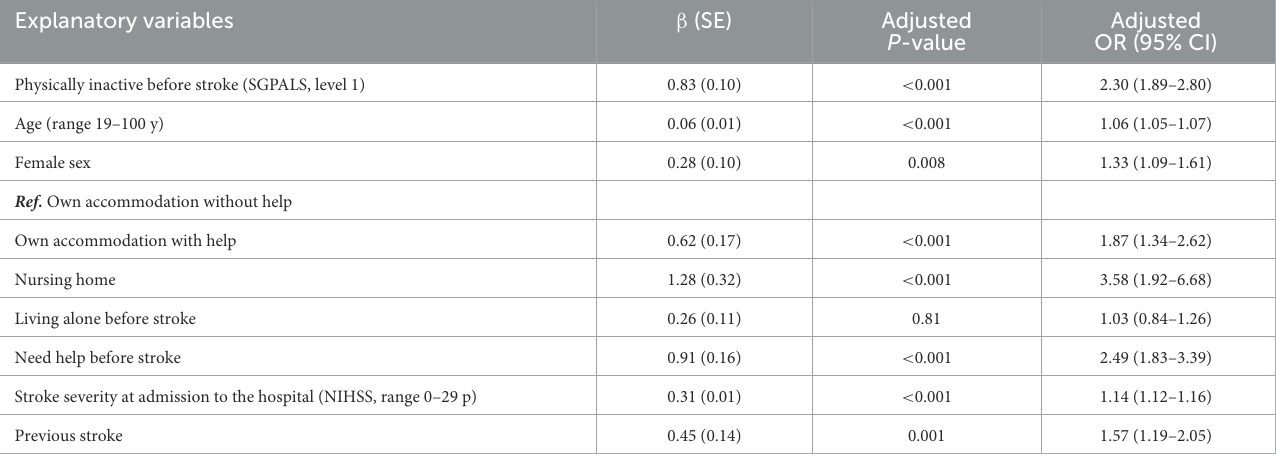
TABLE 2 Results of the multivariable binary logistic regression analysis for explaining dependency in basic activities of daily living 3 months after stroke. Explanatory variables